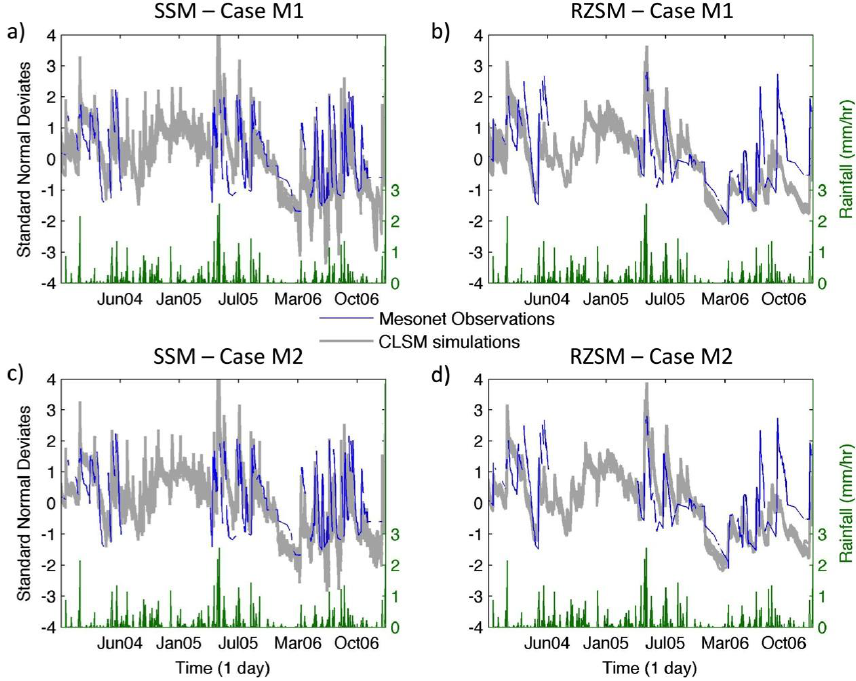
Fig. 6. Same as in Fig. 5 but for a location in the western region of the study area (99.641 ◦ W, 36.831 ◦ N, see Fig. 1). Figure 6 Same as in Figure 5 but for a location in the western region of the study area (99.641W 813 – 36.831N, see Figure 1). 814 error approaches. Specifically, Figs. 5 and 6 show standard- normal deviate time series at two representative Mesonet sta- tions, located, respectively, in the eastern (wetter) and west- ern (drier) region of the study area and at the corresponding 25 km grid cells indicated in Fig.